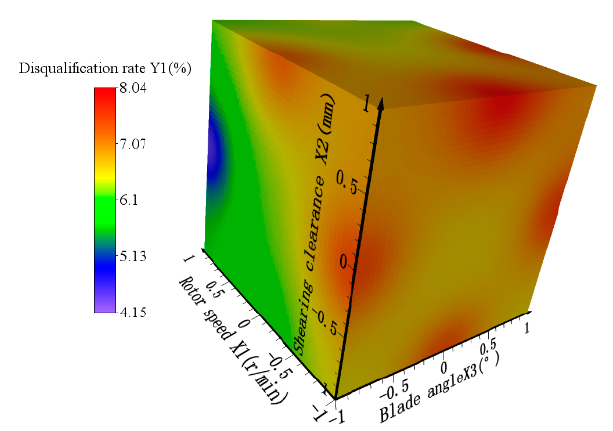
Figure 14. Four-dimensional rendering graph illustrating the influence of the cutter shaft speed, cutting clearance, and cutter edge angle on the disqualification rate. Table 4. Variance and analysis of regression model.